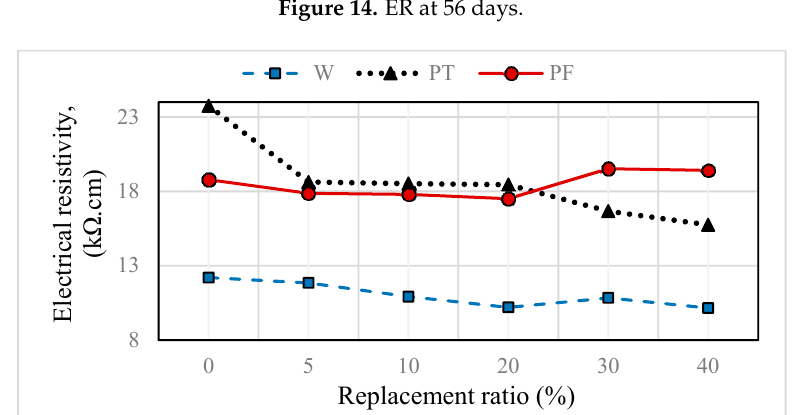
Figure14. ER at 56 days. Figure 14. ER at 56 days. Appl. Sci. 2018 , 8 , x FOR PEER REVIEW